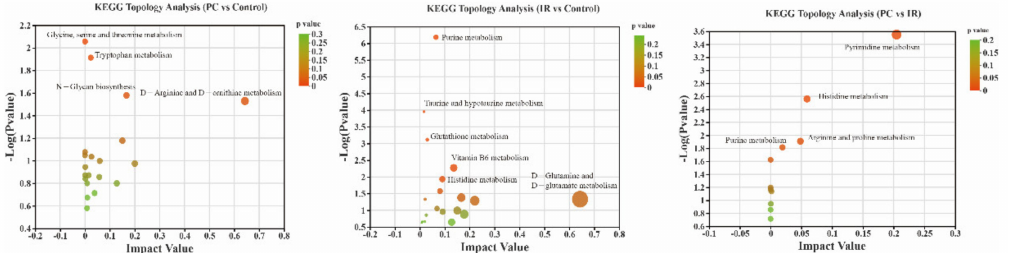
Figure 6. Topology analysis of differentially presented metabolites between PC and control groups, IR and control groups, and PC and IR groups. The X-axis represents the pathway impact, and Y-axis represents the pathway enrichment. Larger sizes and darker colors represent greater pathway enrichment and higher pathway impact values,